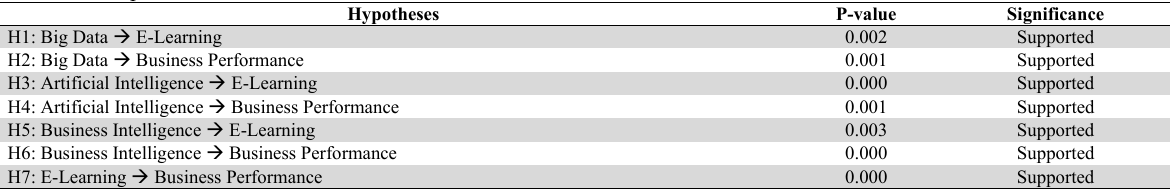
The results of path coefficient